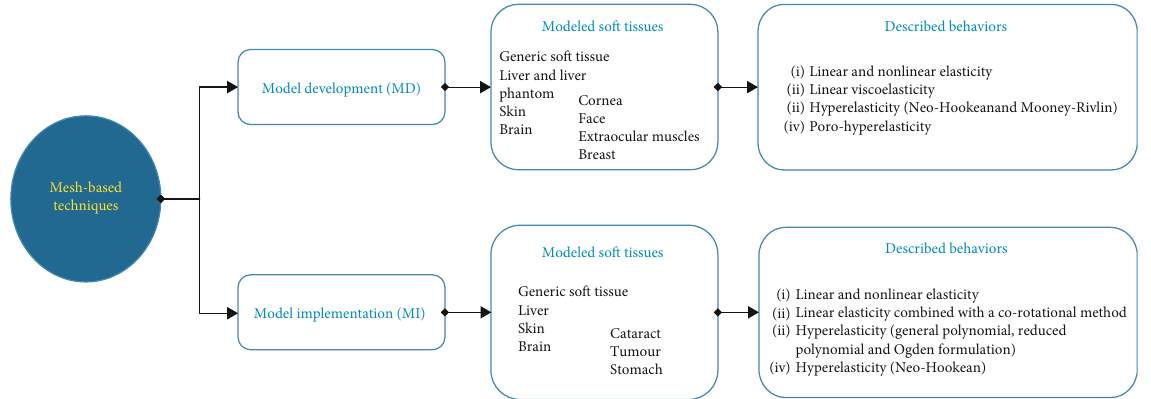
Figure 3: Overview of all modeled soft tissues and di ff erent described behaviors for mesh-based